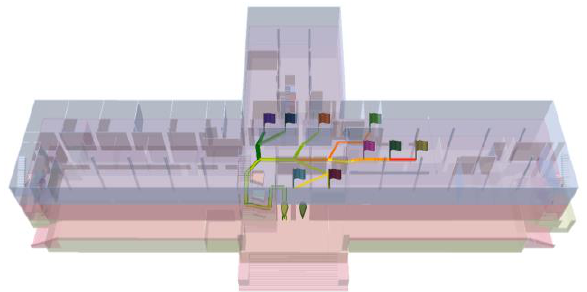
Figure 23. Generated Evacuation Second Floor Routes for First Evacuation Scenario